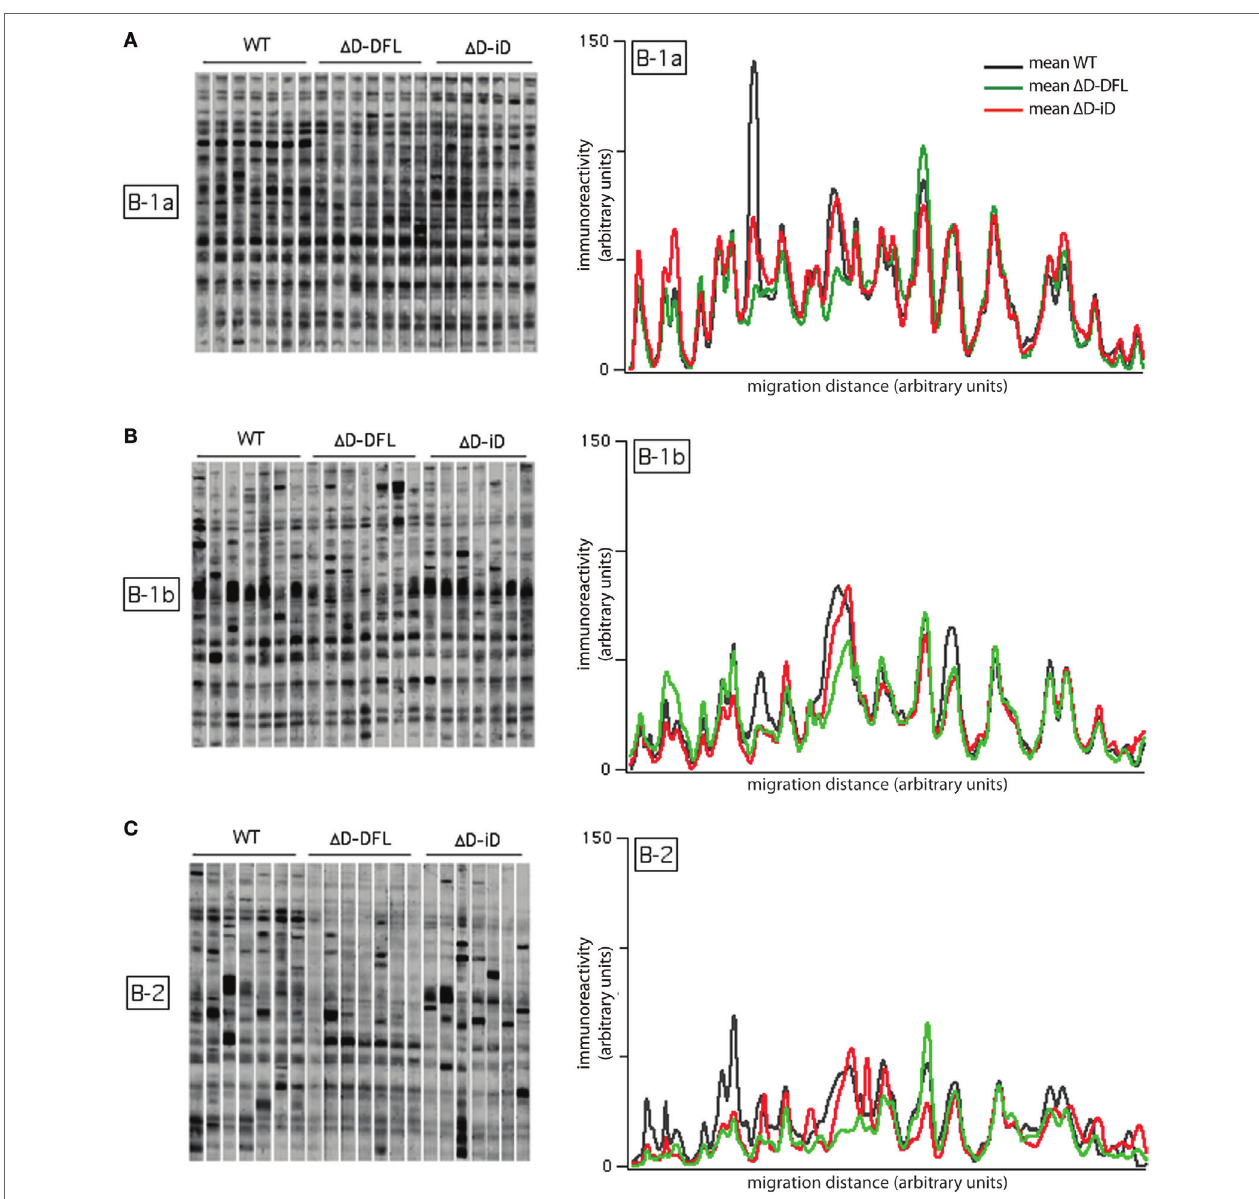
FigUre 3 | self-reactivities of the available repertoire in Perc B cell subsets . Left panels (a–c) show 21 B-1a, B-1b, and B-2 cells culture supernatants (~1,500 responding B cell per culture), respectively, reacting with syngeneic brain extract. Right panels show the mean intensity of reactivities displayed by B-1a (a) , B-1b (B) , and B-2 (c) cells from each mouse genotype. Raw data adapted from Ref.